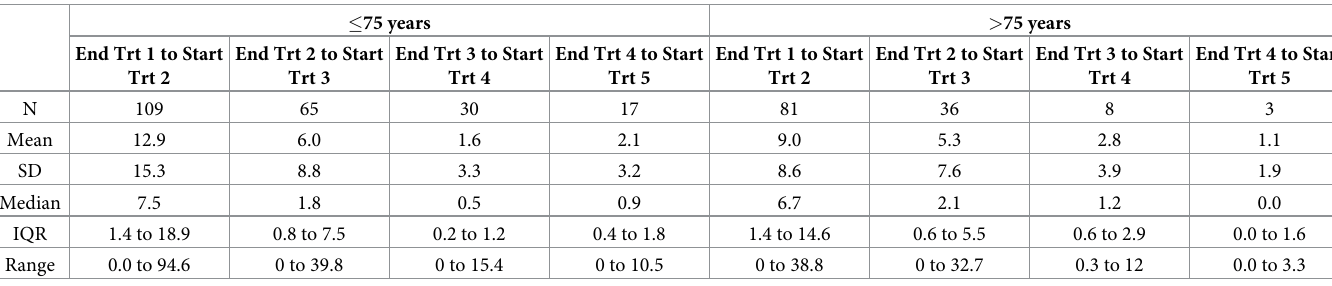
Table 6. Treatment-free interval in months according to age, following first-line and subsequent lines of therapy. � 75 years > 75